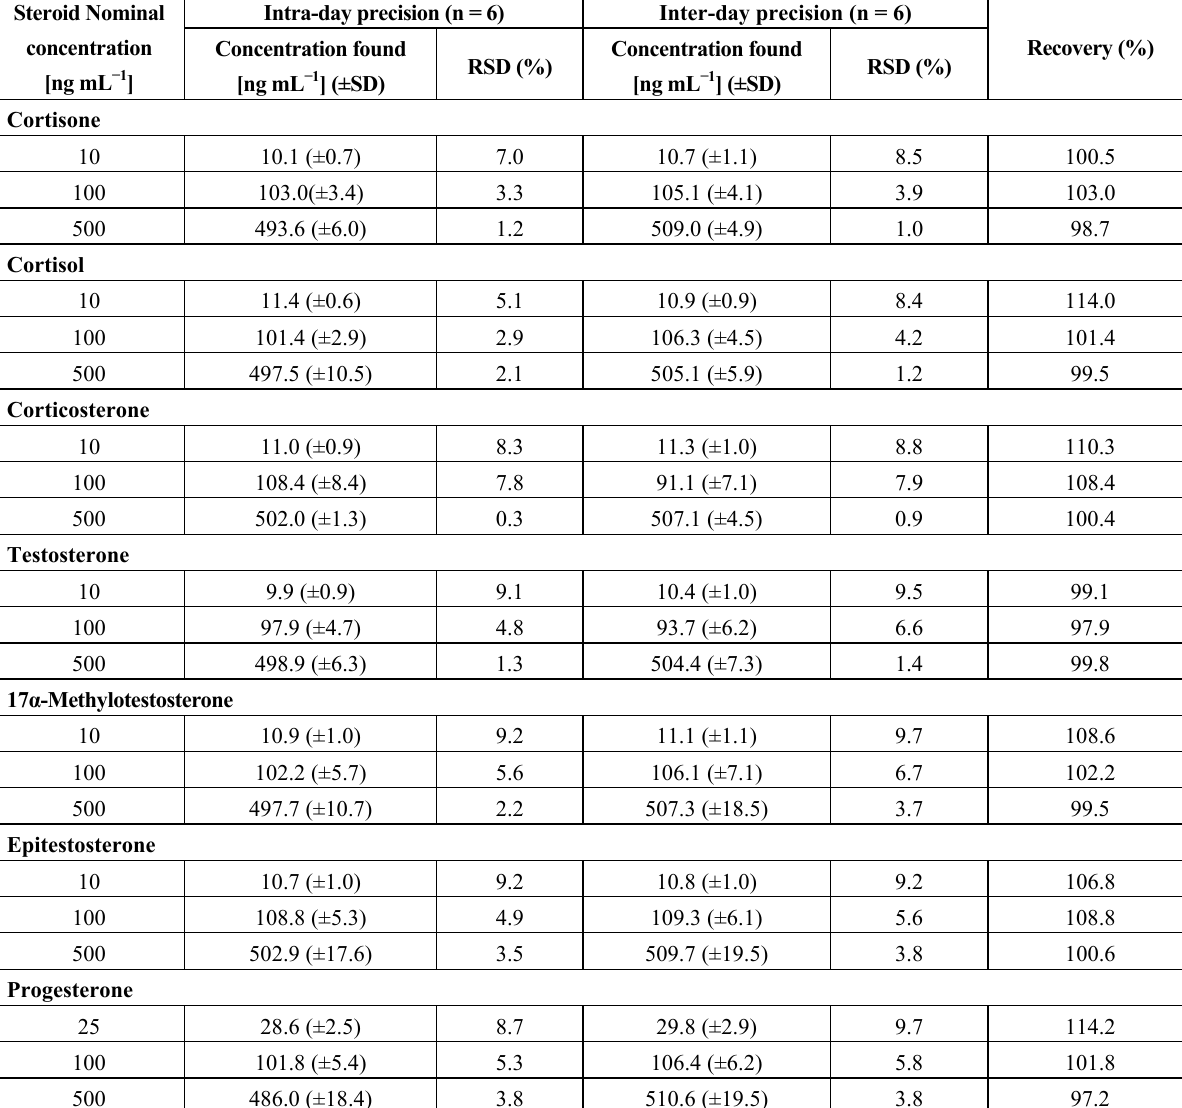
Table 3. Intra-assay precision, inter-day precision, and recovery at three concentration levels for steroid